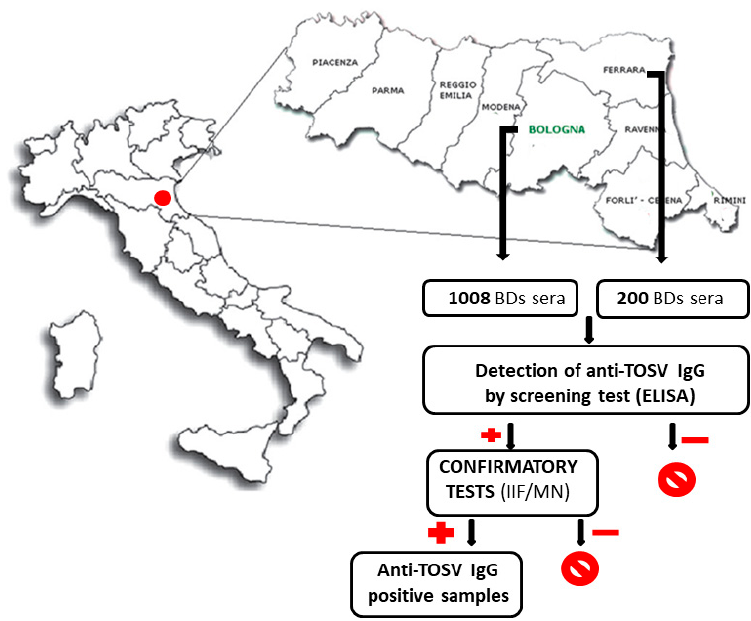
Figure 1. Work-flow of TOSV serosurvey. Blood donor (BD) sera were collected from the Bologna and Ferrara provinces (Northeastern Italy) and tested by ELISA for the presence of anti-TOSV IgG. Samples testing reactive by ELISA were confirmed by indirect immunofluorescence assay (IIF) and microneutralization test (MN).